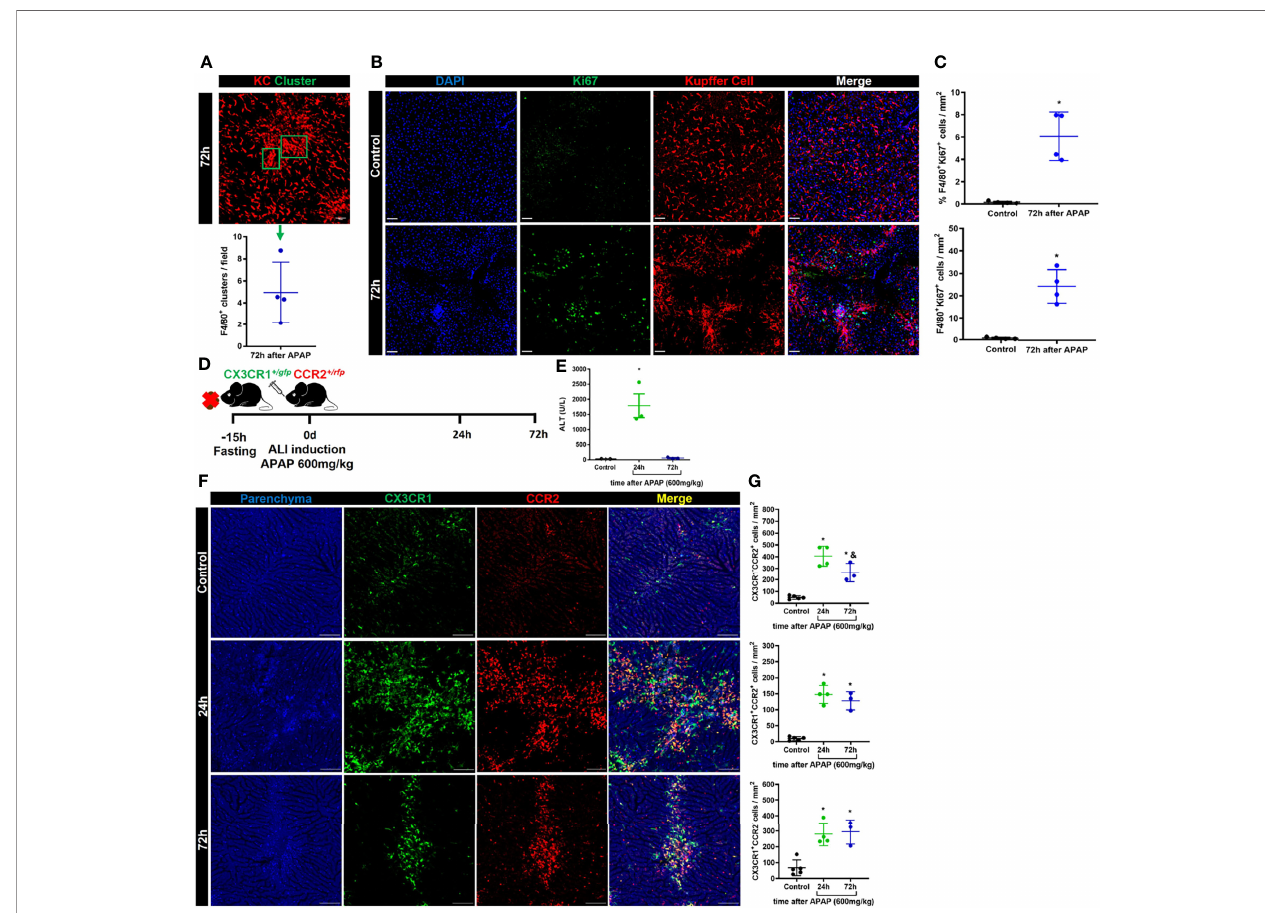
FIGURE 4 | Kupffer cell proliferation and in fi ltration of monocyte-derived cells promote liver niche restoration. (A) Representative IVM image illustrating the Kupffer cell clusters and their quanti fi cation per fi eld in the resolution phase, 72h after APAP administration; scale bar = 50 µm; n = 4 mice per group and 10 images per mice; representative of 2 independent experiments. (B) Evaluation of Kupffer cell proliferation during ALI resolution phase by immuno fl uorescence stained for DAPI (Blue), Ki67 (green), and F4/80 (Red); Representative images of 2 independent experiments; scale bar = 50 µm. (C) Quanti fi cation of % (Upper panel) and numbers (bottom panel) of Kupffer cell/Cluster co-localized with Ki67 staining; n = 4 mice per group and 10 images per mice; representative of 2 independent experiments. (D) Scheme of ALI induction by oral gavage administration of APAP 600mg/kg in 8 – 10-weeks old CX3CR1 /+GFP + CCR2 /+rfp female mice. (E) Measurement of liver injury by serum levels of Alanine aminotransferase (ALT); n =3 mice per group; representative data for 2 experiments. (F) Representative images of IVM assay during ALI to characterize liver architecture (Parenchyma) and monocyte populations; Parenchyma is represented by liver auto- fl uorescence (blue); monocytes CX3CR1 + CCR2 + are represented by yellow cells; monocytes CX3CR1 + CCR2 - are represented by green cells; monocytes CX3CR1 - CCR2 + are represented by red cells; scale bar = 100 µm. (G) Quanti fi cation of each monocyte subset: monocytes CX3CR1 - CCR2 + (Upper panel), monocytes CX3CR1 + CCR2 + (Middle panel), and monocytes CX3CR1 + CCR2 - (Bottom panel); n ≥ 3 mice per group and 10 images per mice; representative of 2 independent experiments. Data are presented as mean ± SEM. * indicates statistical difference to the control group using one-way ANOVA followed and Tukey post-test (* = p < 0.05). & Indicates statistical difference compared to the 24h group using one-way ANOVA followed and Tukey post-test (& = p <